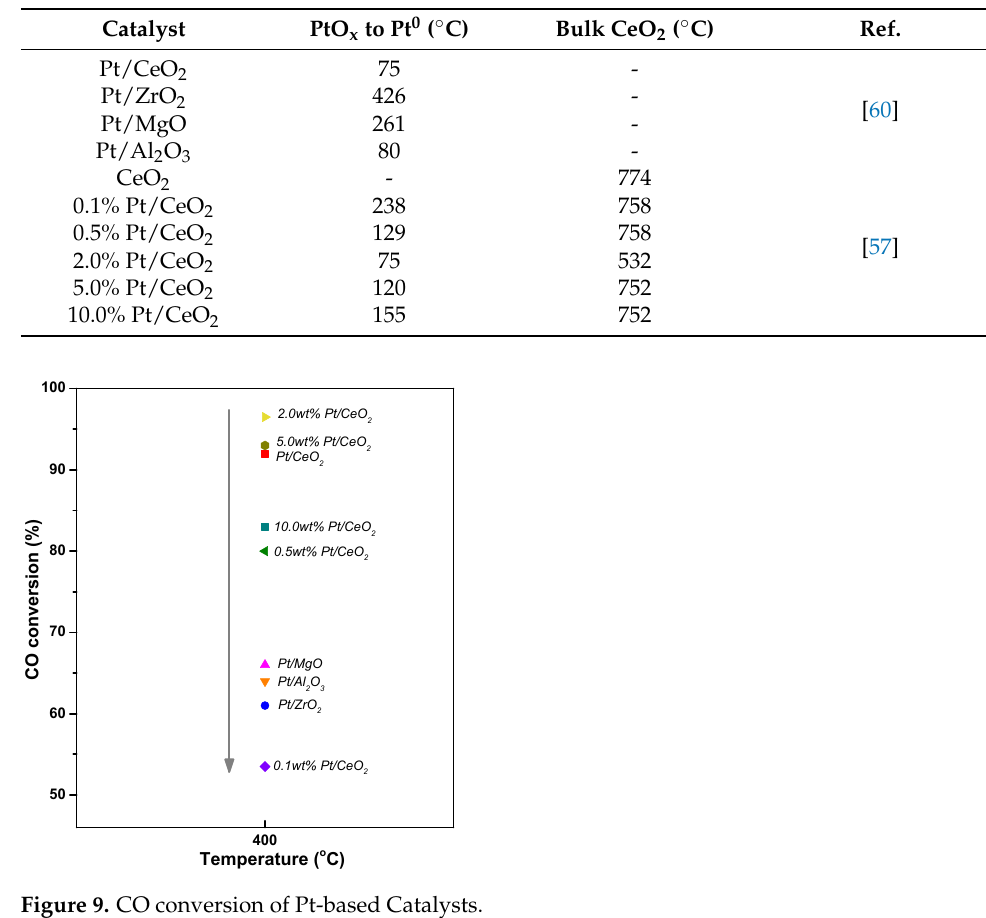
Table 12. Reduction characteristics of Pt-based Catalysts.